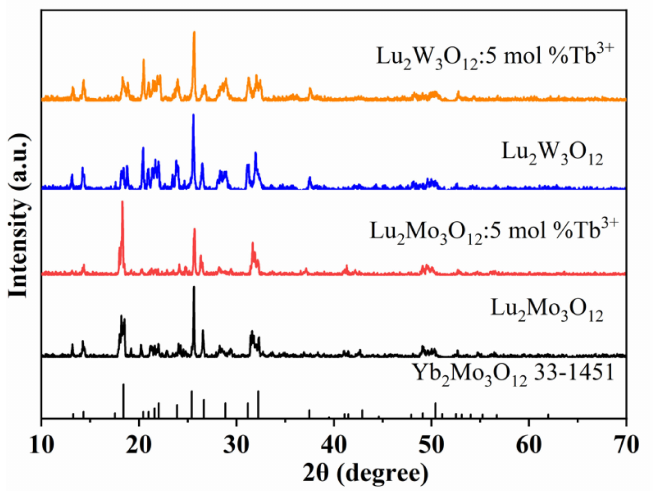
Figure 3. XRD patterns of 5 mol%Tb 3+ -doped and undoped Lu 2 W 3 O 12 and Lu 2 Mo 3 O 12 materials prepared at 1000 ◦ C and reference